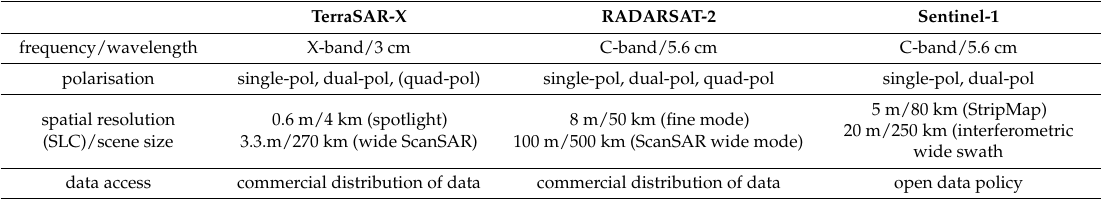
data access commercial distribution of